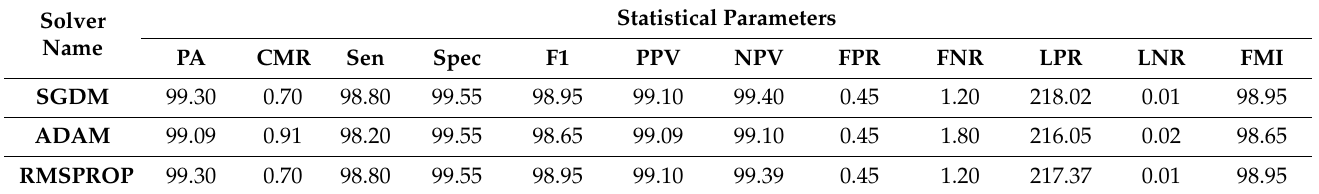
Table 6. Testing statistical parameter results of the proposed model empowered with transfer learning.